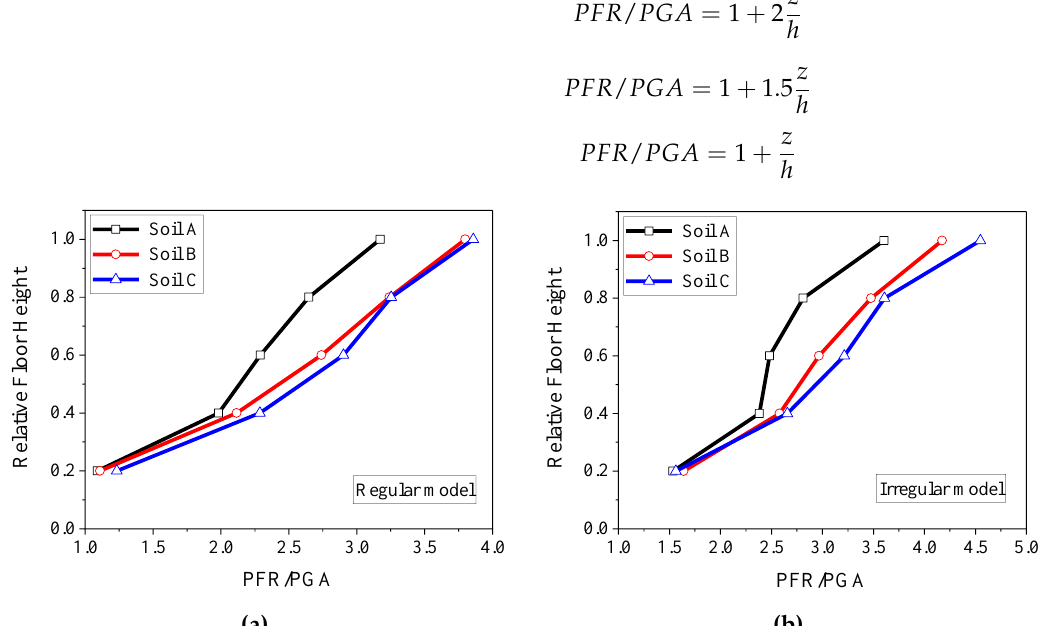
Figure 8. Normalized floor amplification of ( a ) regular building; ( b ) irregular building.